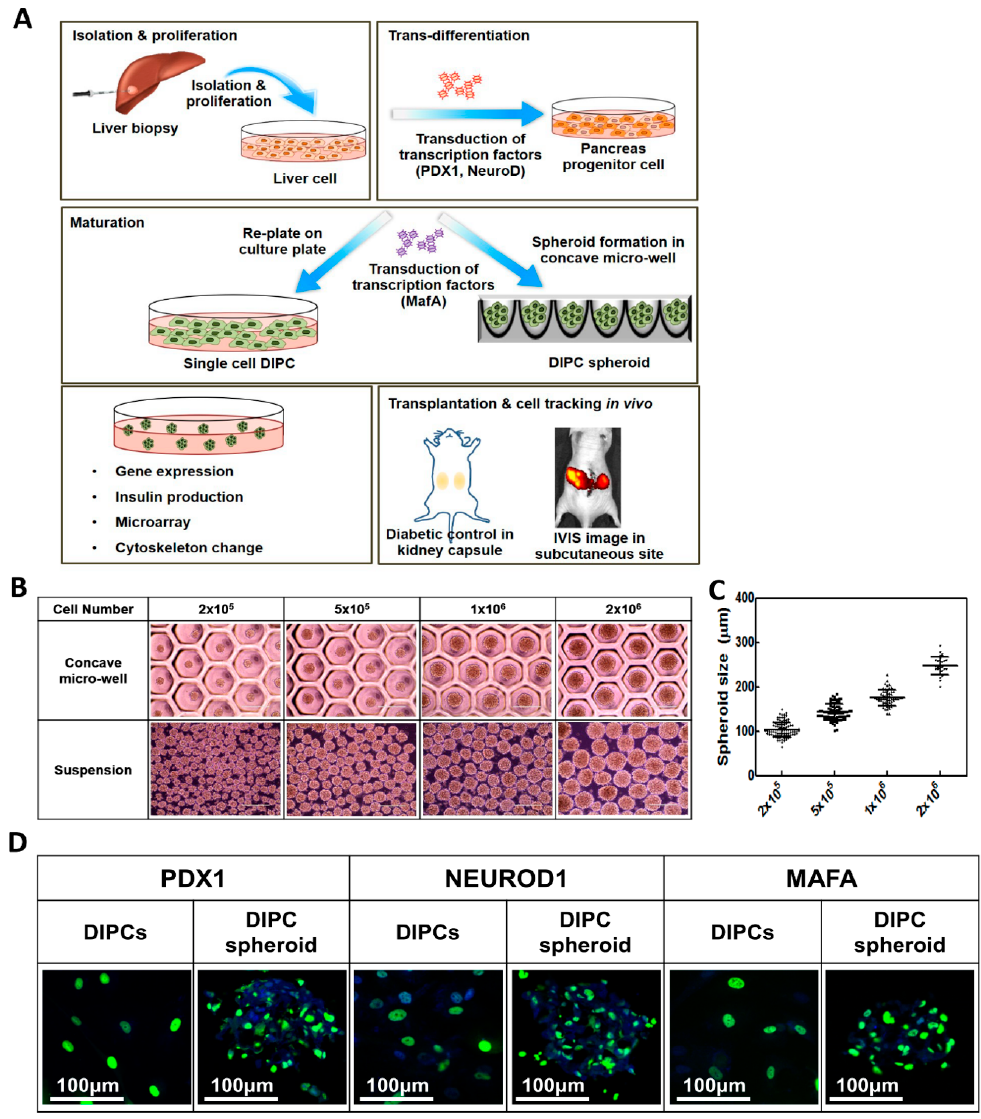
Figure 1. Fabrication of DIPCs and DIPC spheroids. ( A ) Schematic diagram of the experimental procedure. Firstly, adult human liver cells were isolated from liver and trans-differentiated to DIPCs using three pancreatic transcription factors, PDX1, NEUROD1, and MAFA, which were carried by recombinant adenoviruses and sequentially supplemented. To prepare spheroids, cells were seeded in concave microwells. After 24 h, cells aggregated to form spheroids, which were collected by flushing the medium and cultured in suspension culture plates. To compare single DIPCs, cells were cultured in conventional 2-D plates. At day 5, DIPCs and DIPC spheroids were harvested for in vitro assays and in vivo transplanted. ( B ) Images and ( C ) size distribution of DIPC spheroids in concave microwells and suspension. ( D ) Ectopic gene expression (PDX1, NeuroD, and MAFA) in DIPCs and spheroids.